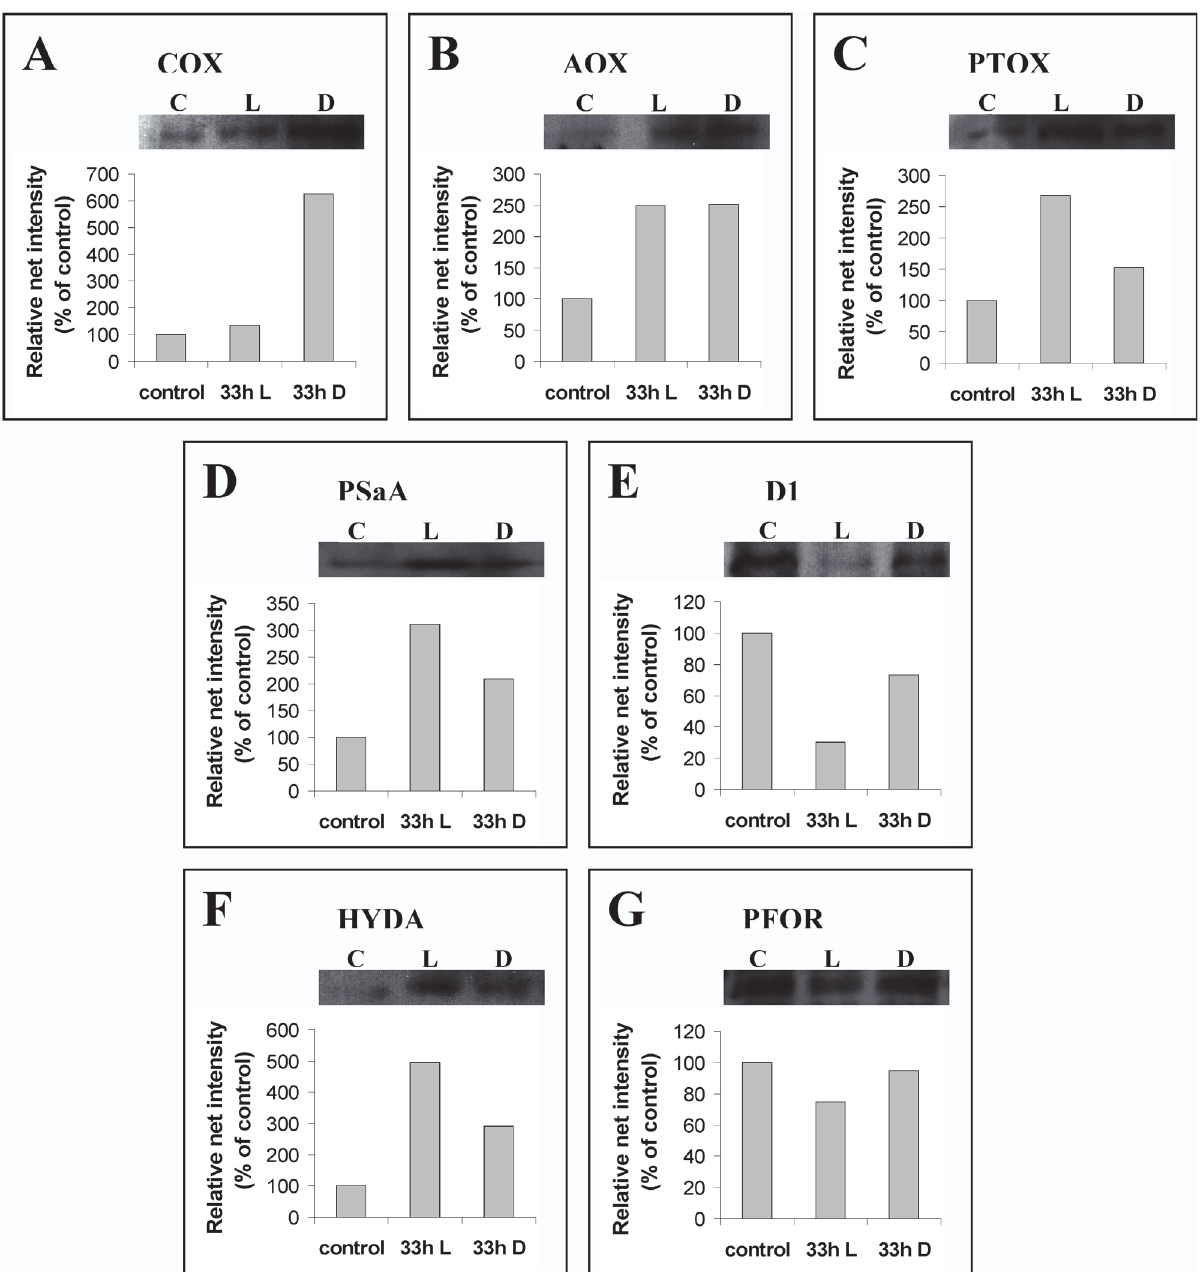
Fig 7. Western blot analysis images and densitometric analysis for (A) cytochromic oxidase (COX), (B) alternative oxidase (AOX), (C) plastid terminal oxidase (PTOX), (D) core protein of PSI (PsaA), (E) core protein of PSII (D1), (F) hydrogenase (HYDA) and (G) pyruvate ferredoxin oxidoreductase (PFOR) after regeneration and after 33 hours of incubation in the hermitically with septum closed bottles. C: Control (after regeneration), L: 33 hours of incubation in light, D: 33 hours of incubation in